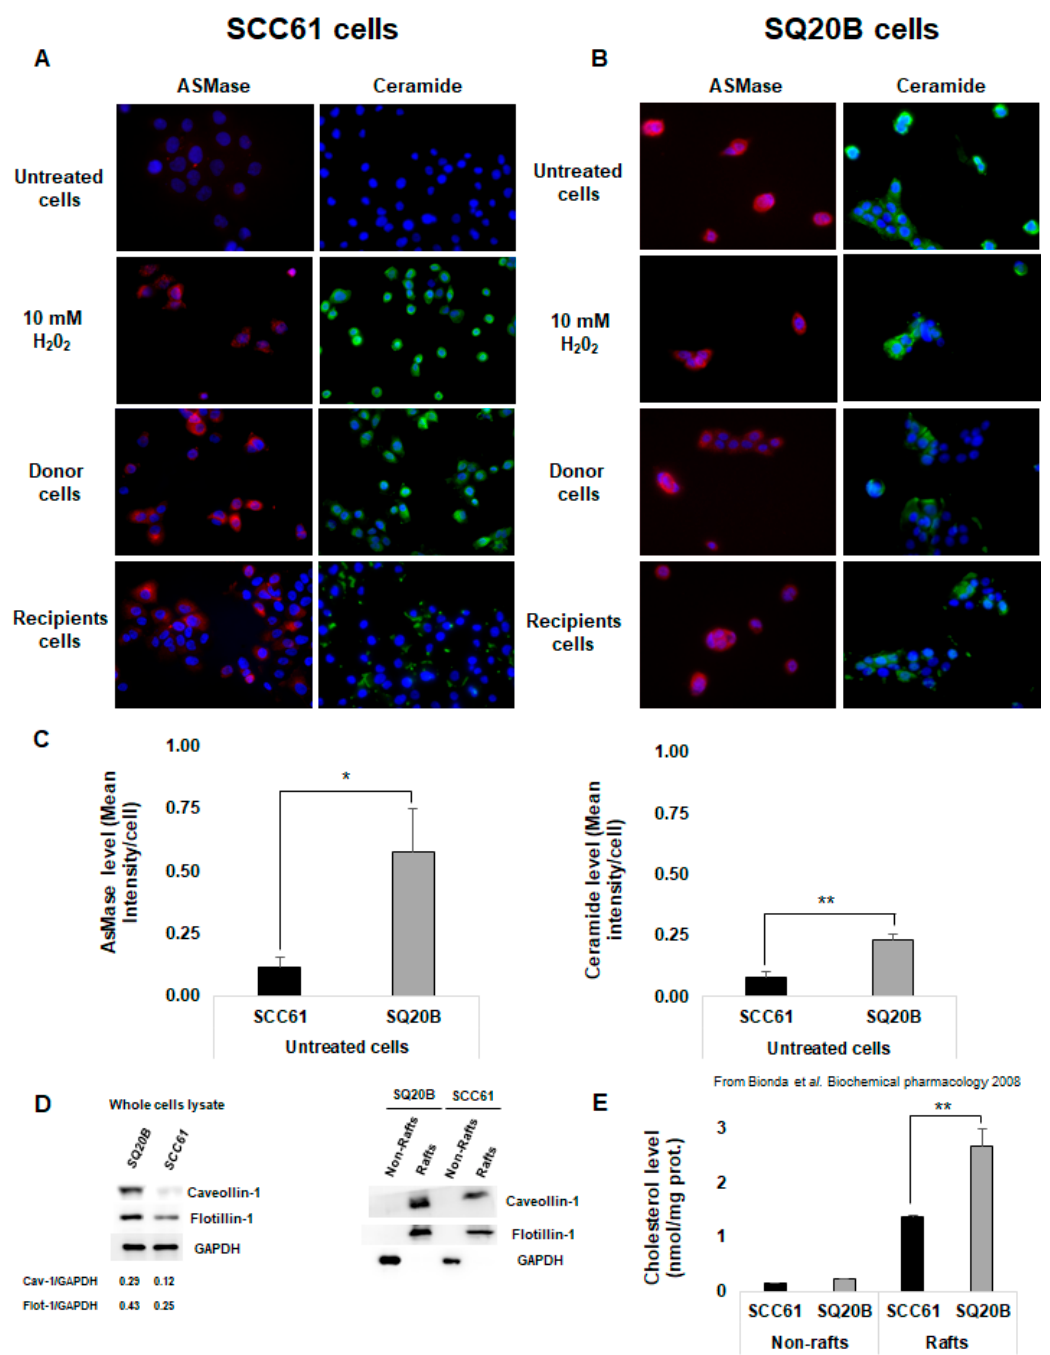
Figure 3. Cell membrane reorganization was radio-induced in radiosensitive SCC61 cells but not in radioresistant SQ20B cells. ASMase activation and ceramide production were measured using immunofluorescence in ( A ) SCC61 cells (donor and recipients) and ( B ) SQ20B cells (donor and recipients). ( C ) ASMase and ceramide levels in basal condition (untreated) in SCC61 and SQ20B cells were quantified using immunofluorescence images. ( D ) Lipid raft markers were assessed using western blotting in both SCC61 and SQ20B cells in the total lysate or in the fractionated Triton-soluble membrane (non-rafts) and lipid raft (rafts) fractions as described. ( E ) Cholesterol level was measured in non-raft and raft fractions isolated from SCC61 and SQ20B cells in basal conditions. The results are the mean ± SD of three experiments performed in triplicate. * p < 0.05, ** p <